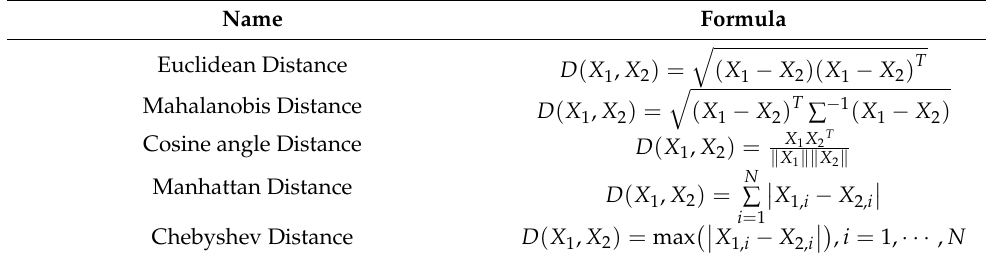
Table 1. The most commonly used distances for similarity measurement in